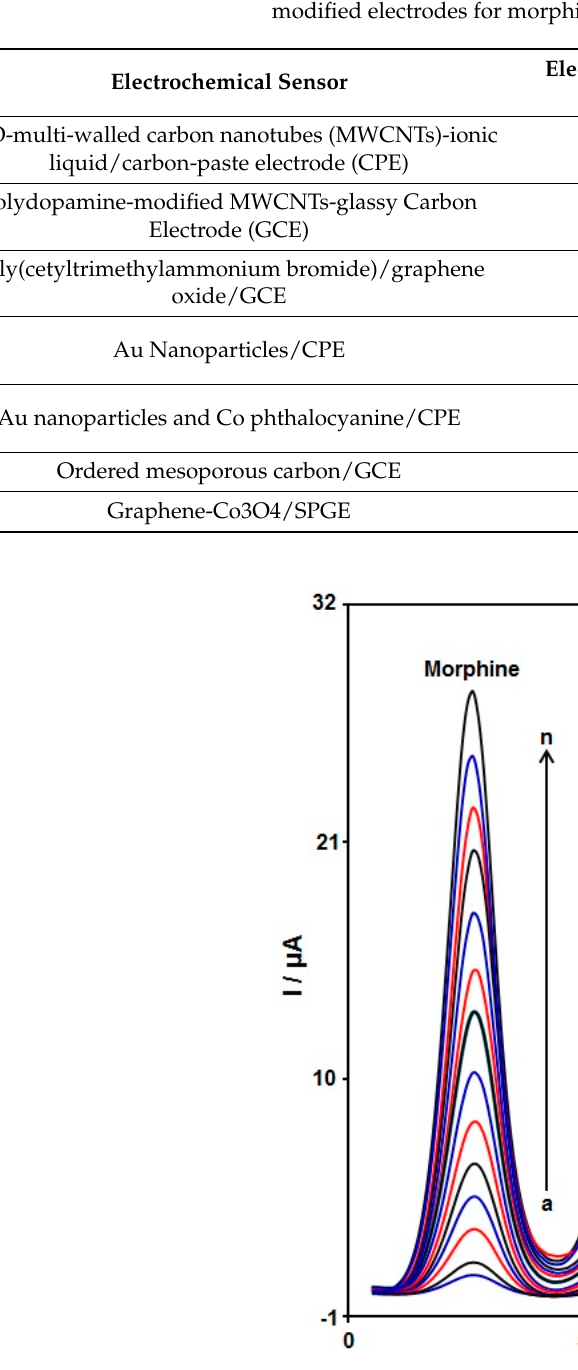
Table 1. Comparison of the efficiency of the graphene-Co3O4/SPGE sensor with other reported modified electrodes for morphine